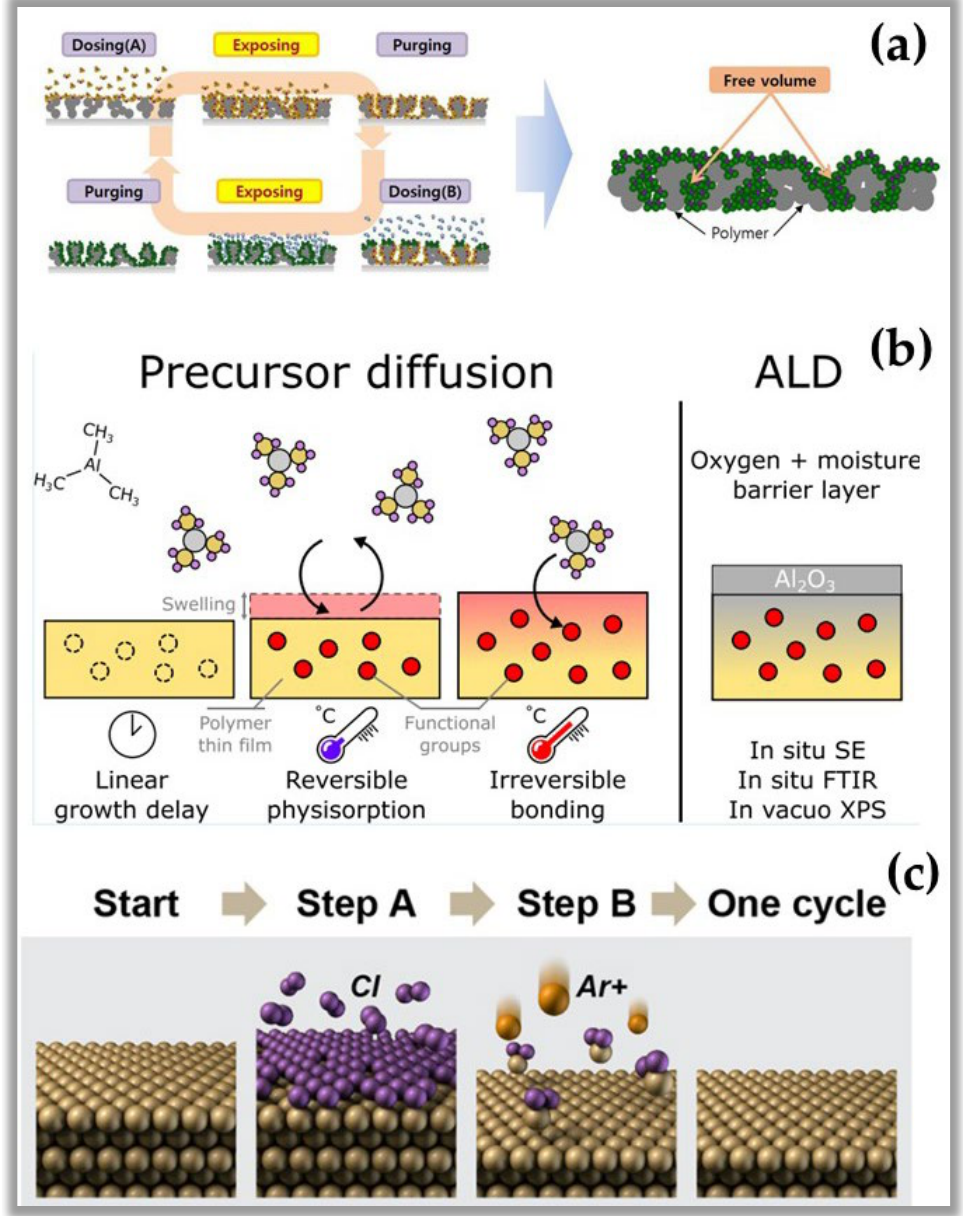
Figure 4. ( a ) Schematic representation of atomic layer infiltration (ALI) [43]. ( b ) Schematic representation of precursor diffusion onto polymer [44]. ( c ) Schematic representation of ALE steps [46]. Subfigure ( a ) reprinted with permission from Ref. [43] by Creative Commons 4.0. Subfigure ( b ) reprinted with permission from Ref. [44] Copyright 2021, ACS. Subfigure ( c ) reprinted with permission from Ref. [46] Copyright 2018, ACS.